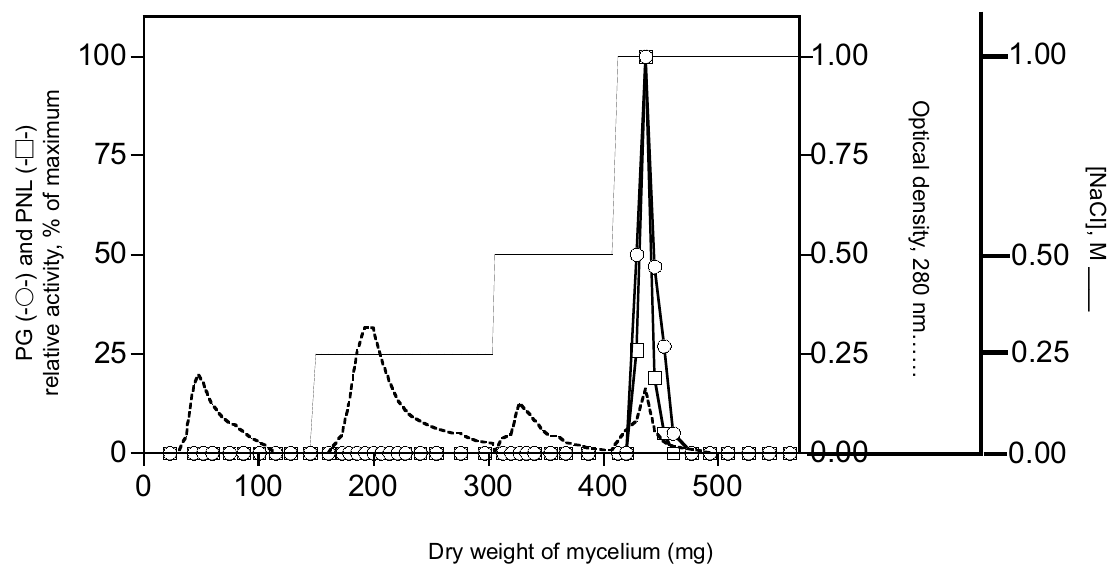
Fig. 7. Elution profile of the desalted concentrated culture filtrate of Heterobasidion annosum intersterile group S, strain 931007 (2.4) grown in liquid growth medium with 1% pectin as the sole carbon source from an Ion exchange chromatography column eluted with a discontinous gradient of NaCl; the polygalacturonase (PG) and pectin lyase (PNL) relative activities are expressed as percentage of